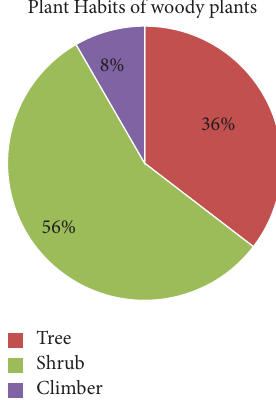
Figure 3: Comparison of the growth forms of woody plant species in Zijje Maryam Church